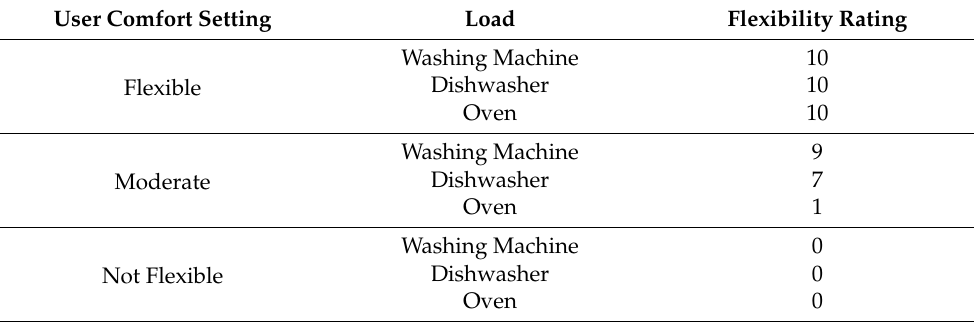
Table 3. User Comfort settings for the considered scenarios.